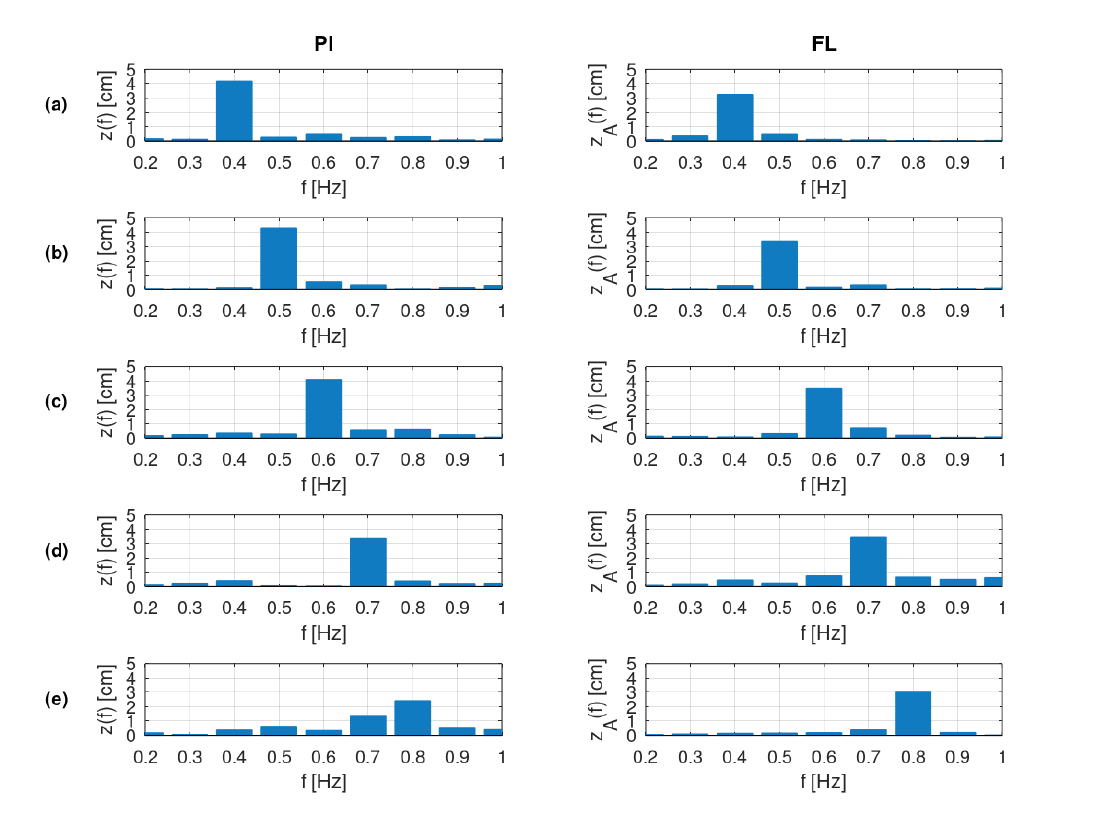
Figure 14. The amplitude spectra of the waves generated under the PI controllers and FL controller with desired wave amplitude of 3.5 cm and frequencies of: ( a ) 0.4 Hz, ( b ) 0.5 Hz, ( c ) 0.6 Hz, ( d ) 0.7 Hz, ( e ) 0.8 Hz.